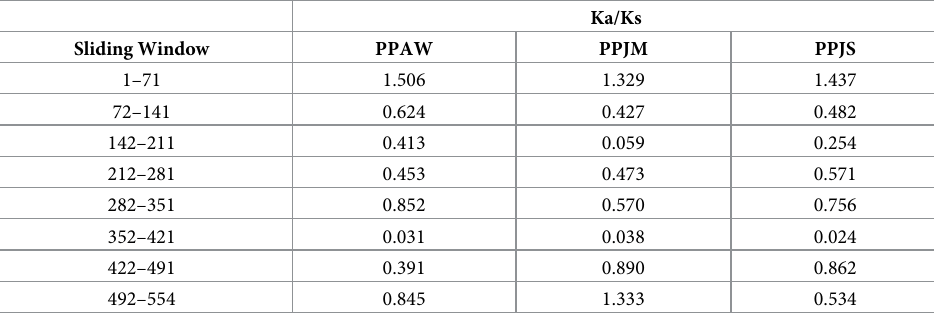
Table 10. PpSP28 sliding window